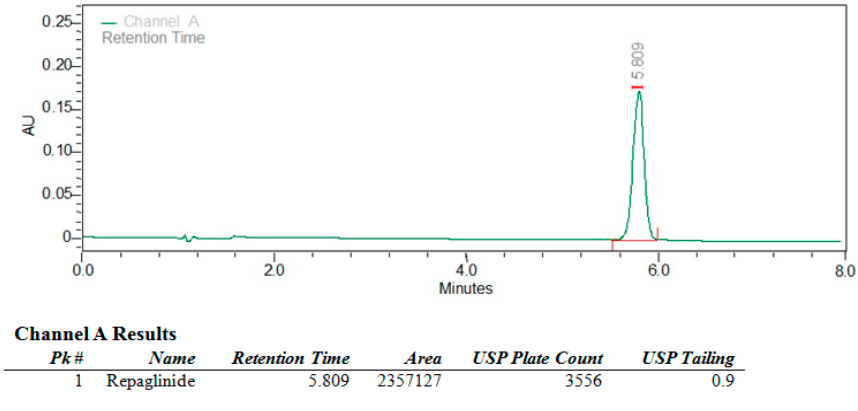
Figure 10. A typical chromatogram of repaglinide by RP-HPLC.